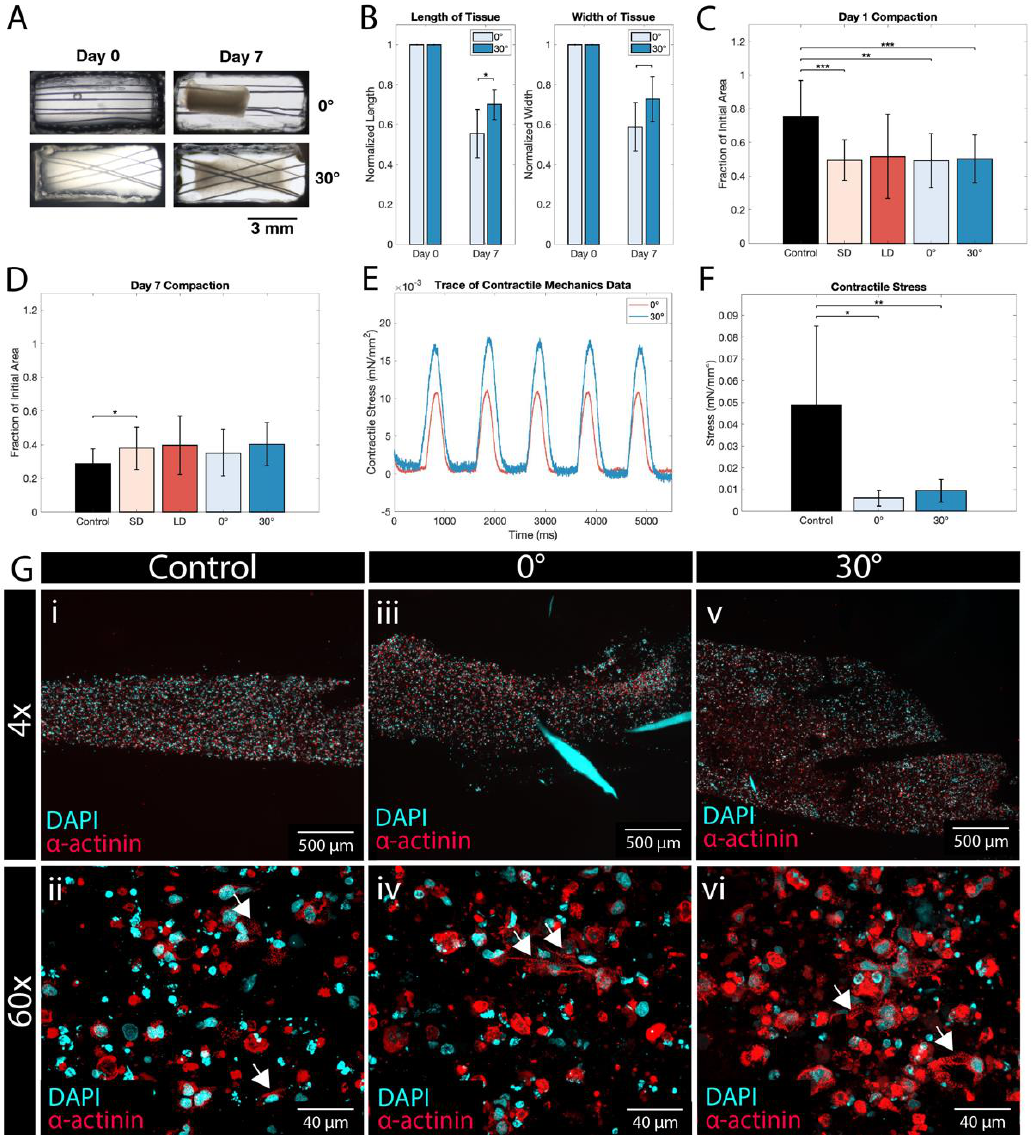
Figure 5. hiPSC-CMs form compacted, contractile tissues on PCL scaffolds. ( A ) Representative images of tissues grown on 0 ◦ and 30 ◦ scaffolds at day 0 and day 7 time points. ( B ) Length and width of tissues compared at day 0 and day 7 time points. ( C ) Day 1 relative compaction of tissues, normalized to day 0 area (SD: 0 ◦ and 30 ◦ small diameter tissues, n = 6; LD: 0 ◦ and 30 ◦ large diameter tissues, n = 27; 0 ◦ : small and large diameter tissues, n = 13; 30 ◦ , small and large diameter tissues, n = 20; control, n = 12). ( D ) Day 7 relative compaction of tissues, normalized to day 0 area (SD: 0 ◦ and 30 ◦ small diameter tissues, n = 6; LD: 0 ◦ and 30 ◦ large diameter tissues, n = 27; 0 ◦ : small and large diameter tissues, n = 13; 30 ◦ , small and large diameter tissues, n = 20; control, n = 12). ( E ) Representative trace of contractile stress generated at 1 Hz pacing by 0 ◦ and 30 ◦ tissues. ( F ) Contractile stress of control, 0 ◦ , and 30 ◦ tissues, calculated as contractile force/cross-sectional area. ( G ) Immunofluorescence staining of engineered tissues using DAPI and α -actinin. Widefield fluorescence images of (i) control, (iii) 0 ◦ , and (v) 30 ◦ tissues at 4 × magnification. Confocal microscopy images of (ii) control, (iv) 0 ◦ , and (vi) 30 ◦ tissues at 60 × magnification; cardiac sarcomeres are highlighted by white arrows. The large areas of cyan fluorescence seen in (iii) are fragments of PCL fibers, which have fluorescent properties. *, **, and *** indicate p ≤ 0.05, 0.01, and 0.001,